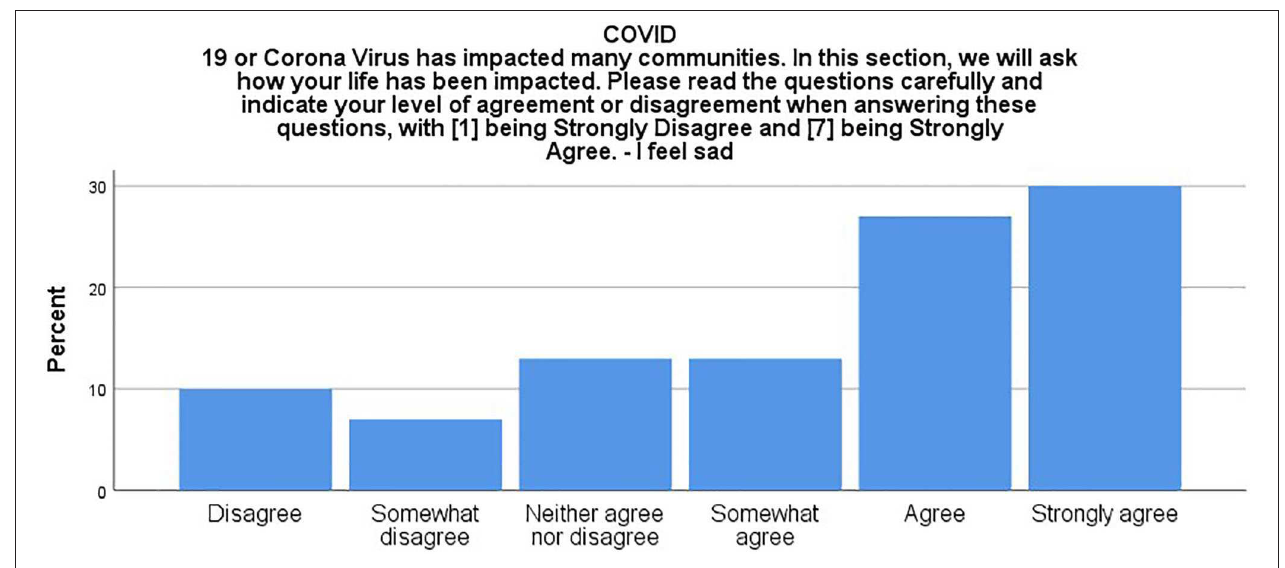
FIGURE 10 | Distribution of participants reporting feeling